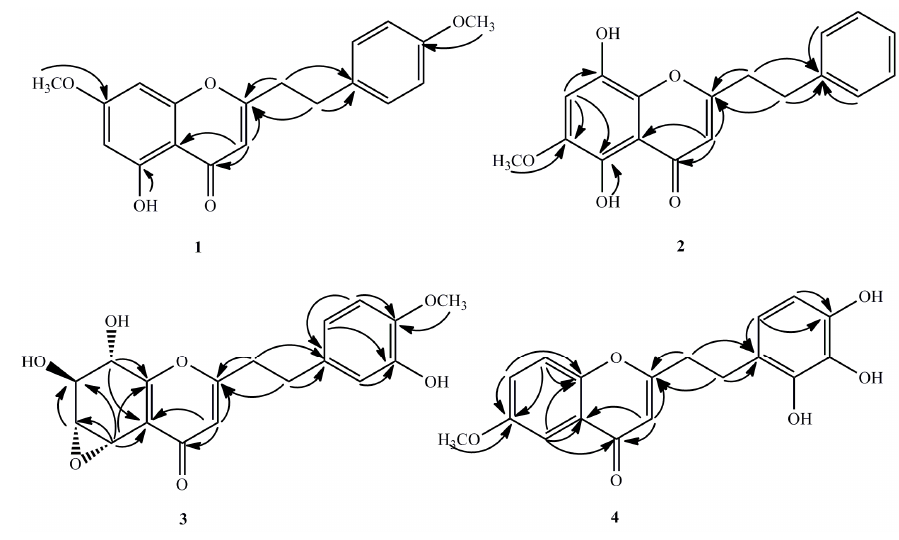
Figure 2. Key HMBC correlations of compounds 1 – 4.